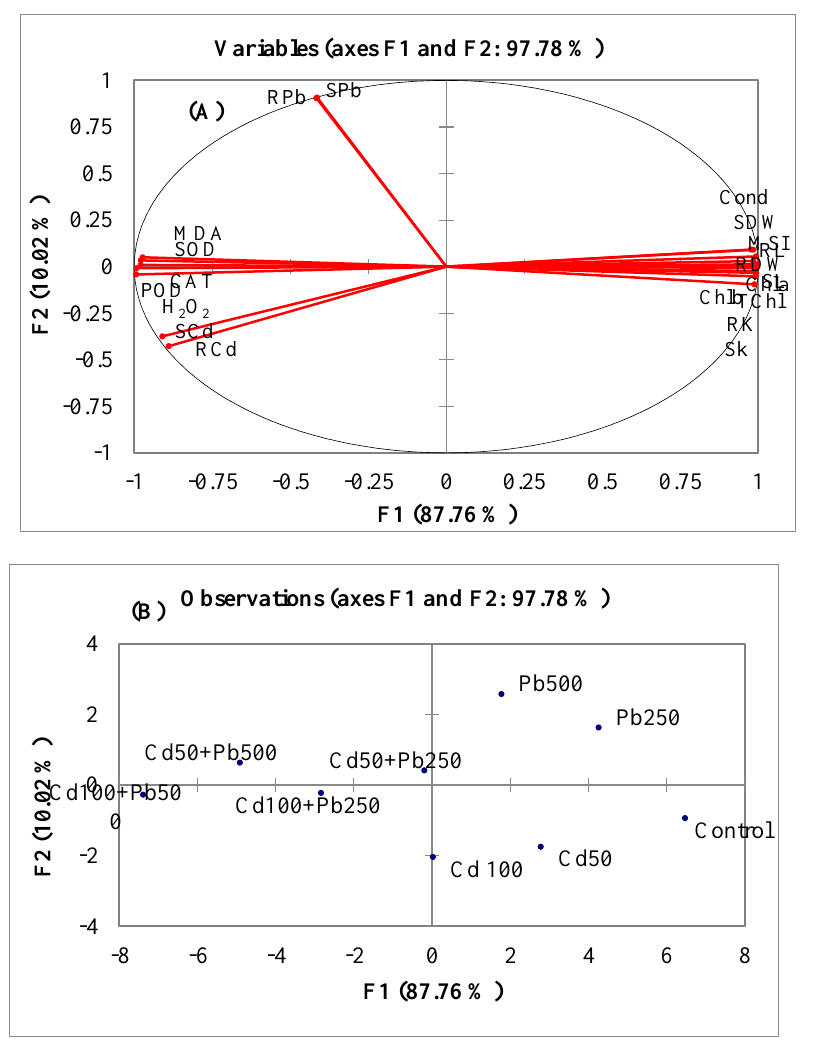
Figure 5. Comparison of different response variables ( A ) and different treatments ( B ) of quinoa exposed to Cd and Pb treatments using principal component analysis.